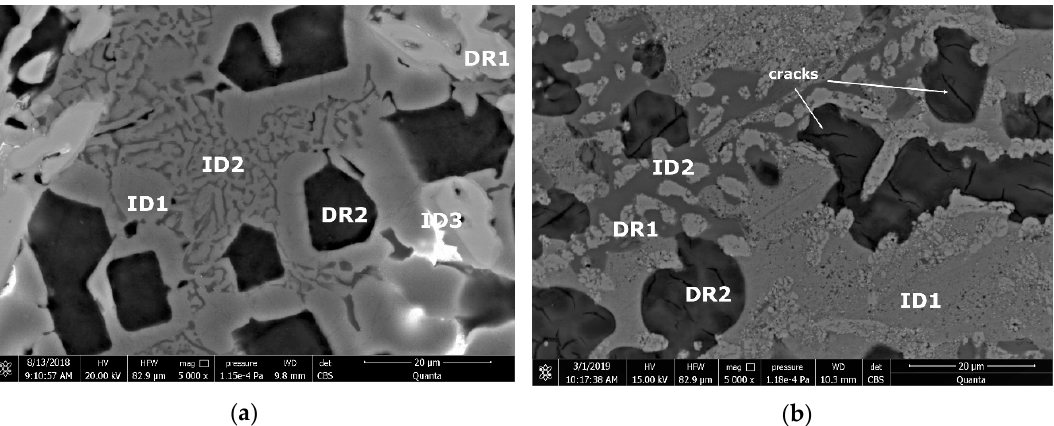
Figure 15. SEM images of ( a ) as-cast and ( b ) annealed cast Al 3 Mn 0.2 Zn 0.3 Mg 0.7 Si 0.8 alloy. DR—dendritic area; ID—interdendritic area; ID1,2,3, and 4—interdendritic phases (Table 5). Table 5. EDS analyses results for Al 3.4 Cu 0.5 Si 0.2 Zn 0.5 Mg 0.2 alloy.